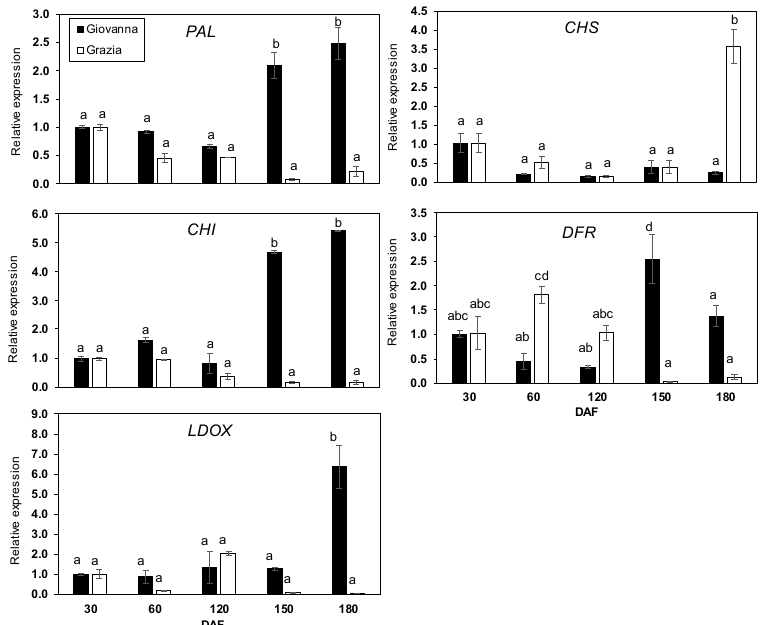
The relative levels of five common genes of the flavonoid biosynthetic pathway ( PAL , CHS , CHI , DFR and LDOX )—a specific anthocyanin gene ( UFGT ) and genes coding for enzymes implicated in the synthesis of flavonols (FLS) and flavan-3-ols (LAR and ANR)— were analyzed over the five developmental stages of dark-blue and white myrtle fruit (Figures 1 and 2). The relative levels of the analyzed genes showed two distinct patterns of expression between the “Giovanna” and “Grazia” cultivars. In the dark-blue “Giovanna” fruit, the accumulation of PAL , CHI , and UFGT transcripts showed a sharp increase during the last stages of berry maturation at 150 and 180 DAF (days after full blooming) (Figures 1 and 2). Moreover, DFR and FLS showed peak expression at 150 DAF, while LDOX showed a peak at 180 DAF. It is important to note that UFGT transcript expression increased by more than 200 times at 180 DAF (Figure 2). However, the CHS transcript did not vary throughout the development (Figure 1). Regarding the white “Grazia” cultivar, it is interesting to note that only the increase in CHS and the decrease in DFR expression showed significant differences. Thus, the relative change in CHS was approximately 2.5-fold at 180 DAF (Figure 1), whereas, in the case of DFR , (Figure 1) it was two-fold at 60 DAF and decreased with ripening. Finally, the LAR and ANR genes, which are implicated in flavan-3-ol biosynthesis, presented a similar pattern of accumulation in both cultivars. A significant decrease in the expression of both genes throughout the development period was observed. In the dark-blue fruit, the LAR gene decreased by about 60% at ripening compared to at 30 DAF, whereas ANS decreased by about 98% in ripe fruit compared to at 30 DAF (Figure 2).